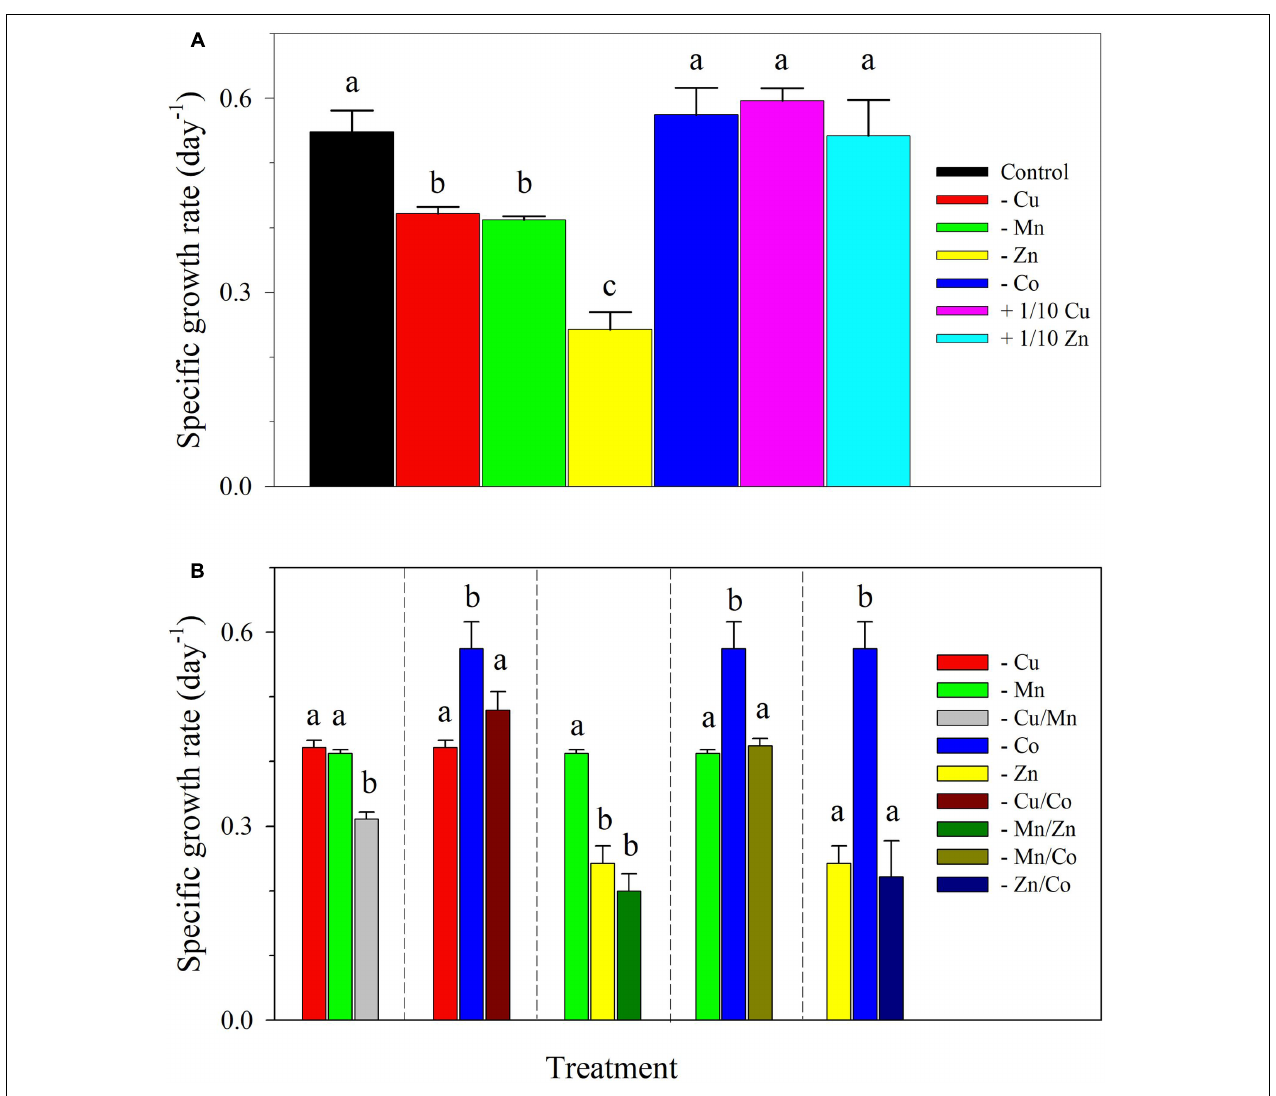
FIGURE 1 | Specific growth rates of Symbiodinium kawagutii subjected to different trace metal conditions. (A) Independent effect of lack or lower concentration of a metal, and (B) interactive effects of lack of a pair of metals. The control treatment was grown with 1.25 nM Fe (cid:48) , 125 pM Zn (cid:48) , 5 pM Cu (cid:48) , 4.2 nM Mn (cid:48) , and 20 pM Co (cid:48) . The values represent means ± SD ( N = 3, P < 0.05, ANOVA, post hoc Tukey HSD).